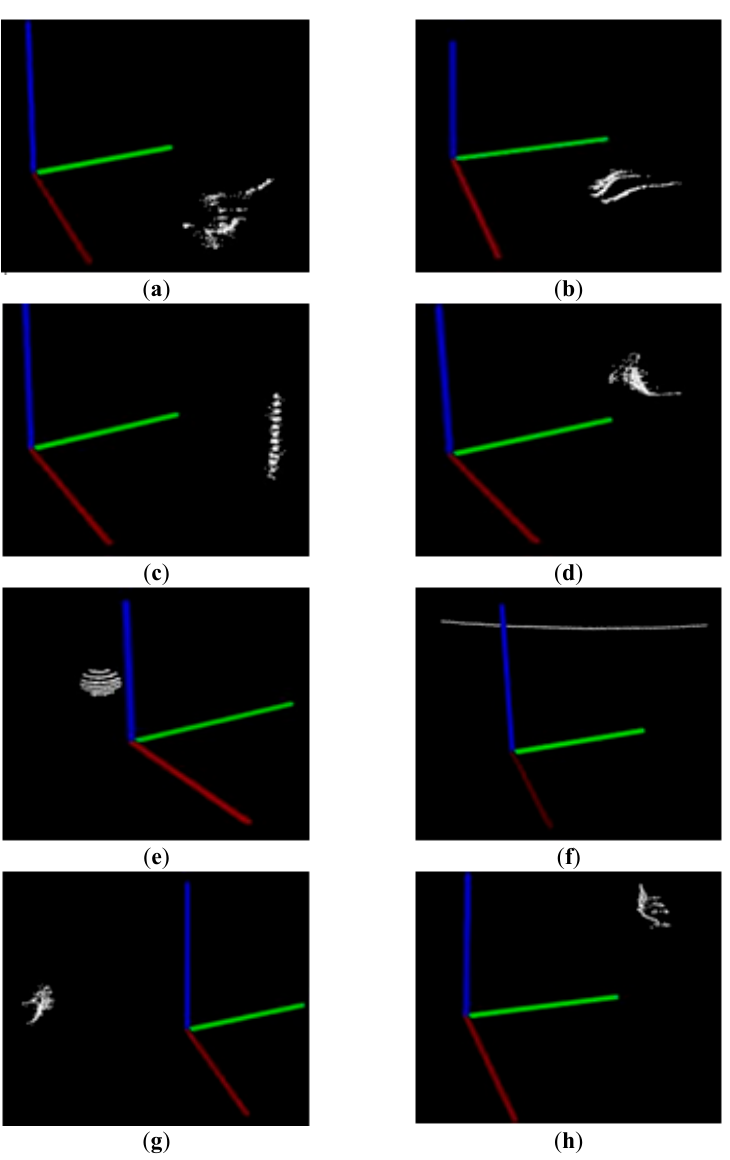
Figure 8. The segmentation results of Euclidean clustering: ( a ) The right chair; ( b ) The legs of the middle chair; ( c ) The pneumatic pole of the black chair; ( d ) The back of the middle chair; ( e ) The target sphere segmented; ( f ) The edge of window; ( g ) The part of chair near the air conditioning; ( h ) The back of blue chair.